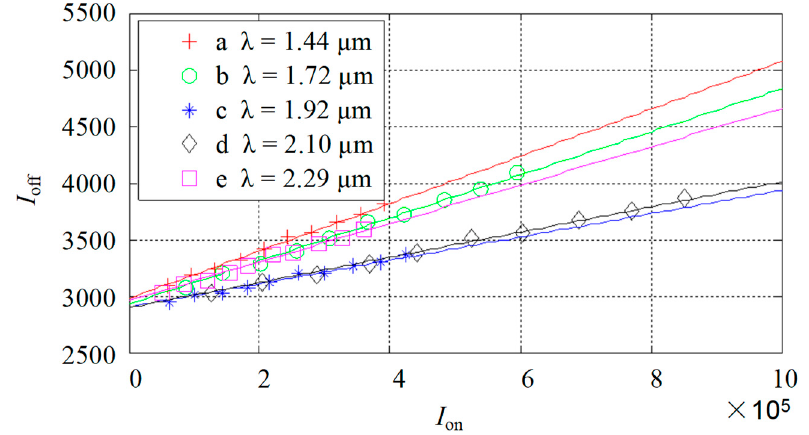
Figure 2. The measurement results of stray light: I on and I off represent the detected light signals when all the micro-mirrors are in the “on” state and “off” state, respectively. Curves a, b, c, d, and e represent the relationships of I on and I off when the wavebands of the inserted filter are 1.44 µ m, 1.72 µ m, 1.92 µ m, 2.10 µ m, and 2.29 µ m, respectively.